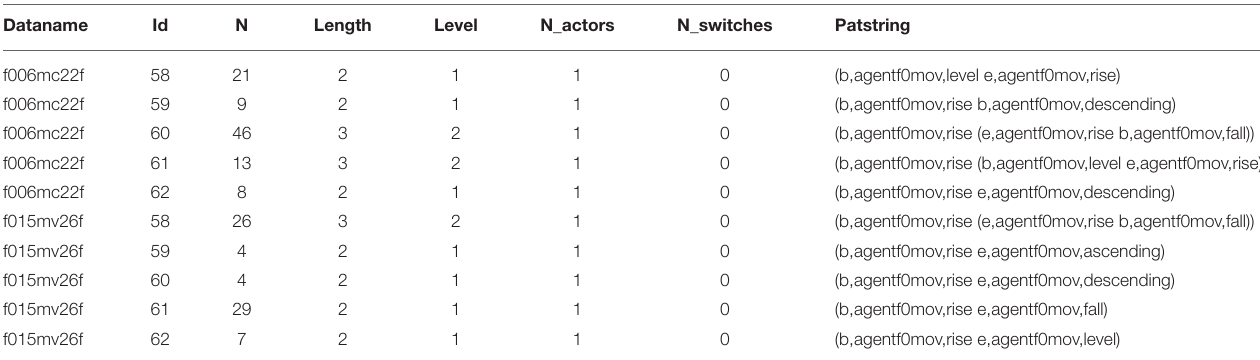
TABLE 1 | Identification of patterns using dataname and id attributes in patstring.txt